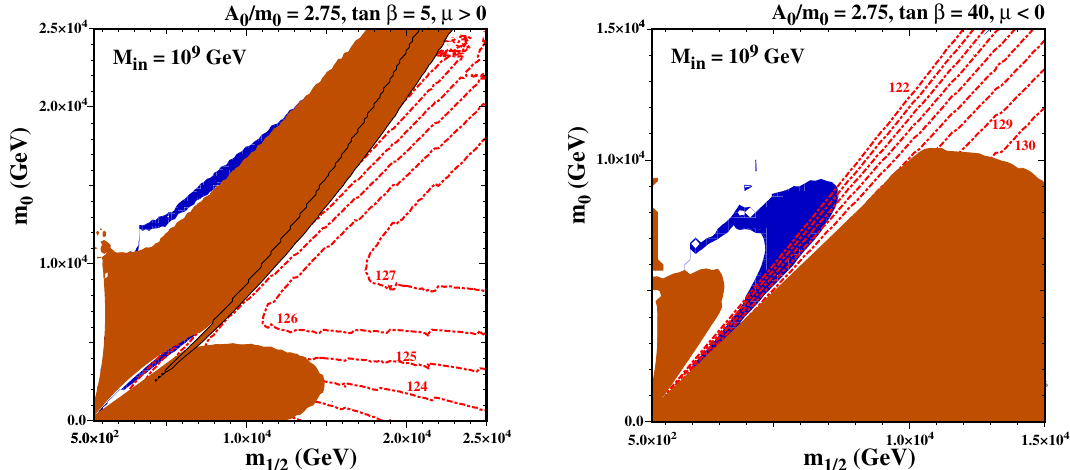
Fig. 9 The ( m 1 / 2 , m 0 ) planes for sub-GUT models with M in = 10 9 GeV and A 0 = 2 . 75 m 0 , for tan β = 5 (left panel) and tan β = 40 (right panel). The shadings are the same as in Fig. 8